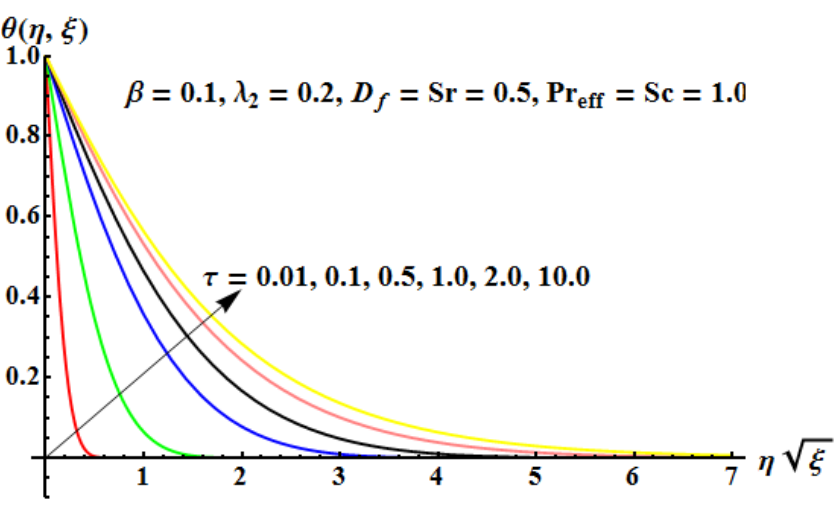
Figure 5. Influence of τ on f (cid:48) ( η , ξ ) .